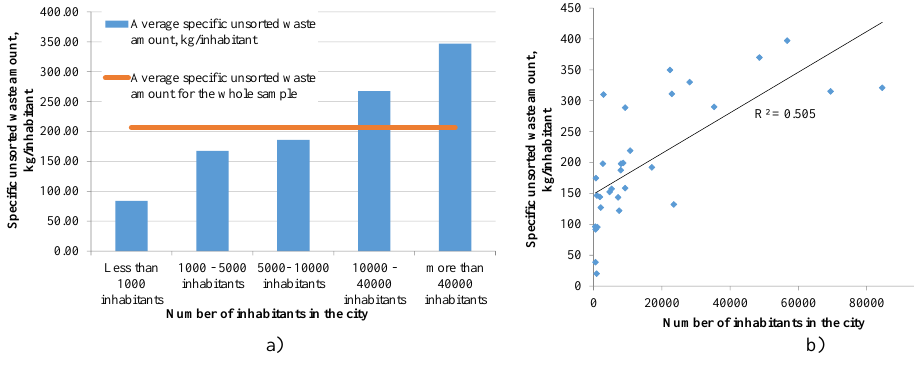
Fig. 1. Specific amount of unsorted municipal waste in the analysed cities. (Note: Riga is excluded from dataset in the Fig. 1(b), due to its significantly larger number of